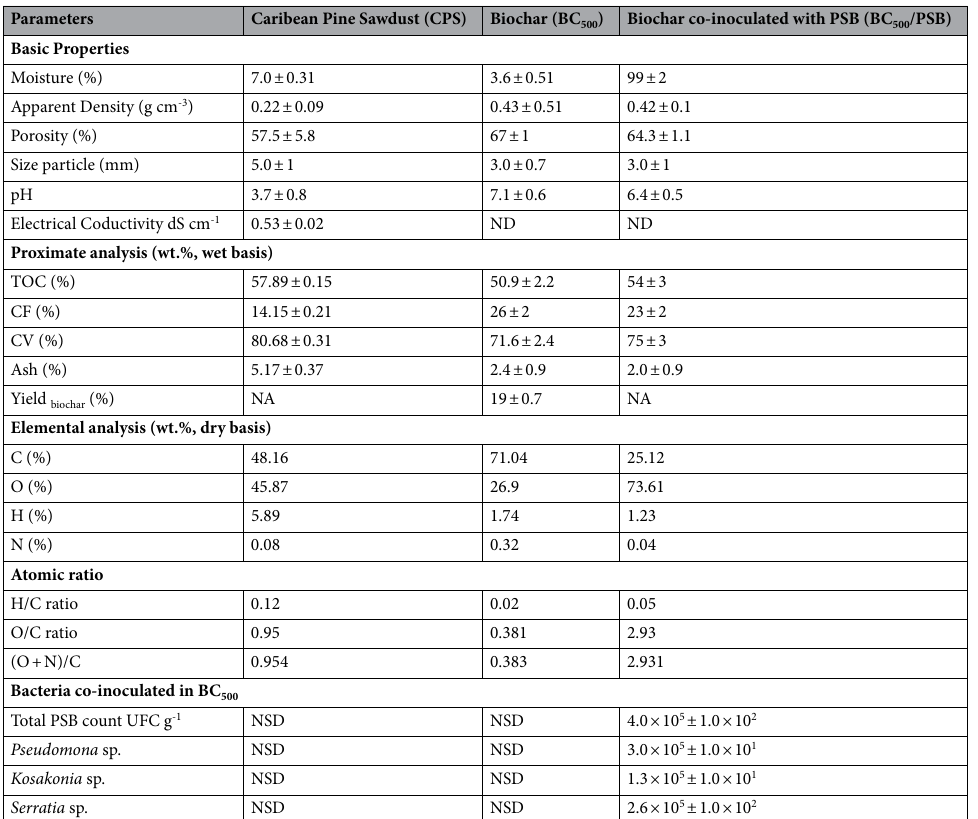
Table 2. Proximate and elemental analysis for Caribbean pine sawdust (CPS), biochar produced at 500 °C 1/h (BC 500 ) and co-inoculation process with PSB (BC 500 /PSB). * NSD: Not